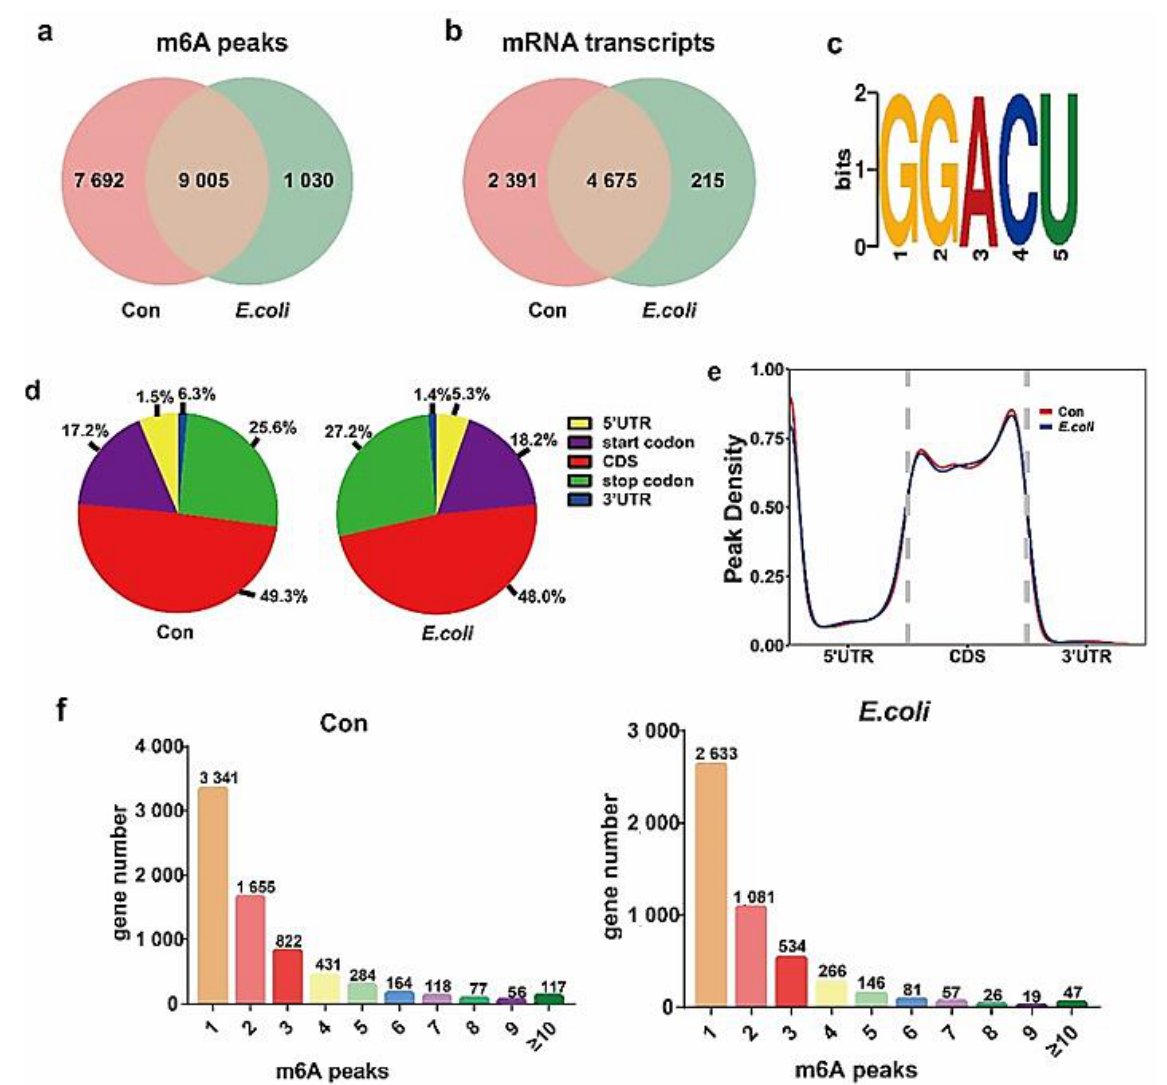
Figure 2. Overview of m 6 A methylation map in Con and E. coli groups. ( a ) Venn diagram showing the specific and common peaks between two groups. ( b ) Venn diagram displaying the specific and common mRNA transcripts between the Con and E. coli groups. ( c ) RRACH sequence motif enrichment of the m 6 A peaks in the Con and E. coli groups. ( d ) Pie charts demonstrating m 6 A peak distribution in the gene structures of mRNAs. ( e ) Metagene plots displaying the regions of m 6 A peaks identified across the transcripts in the Con and E. coli groups. ( f ) The number of m 6 A peaks per gene in the Con and E. coli groups.